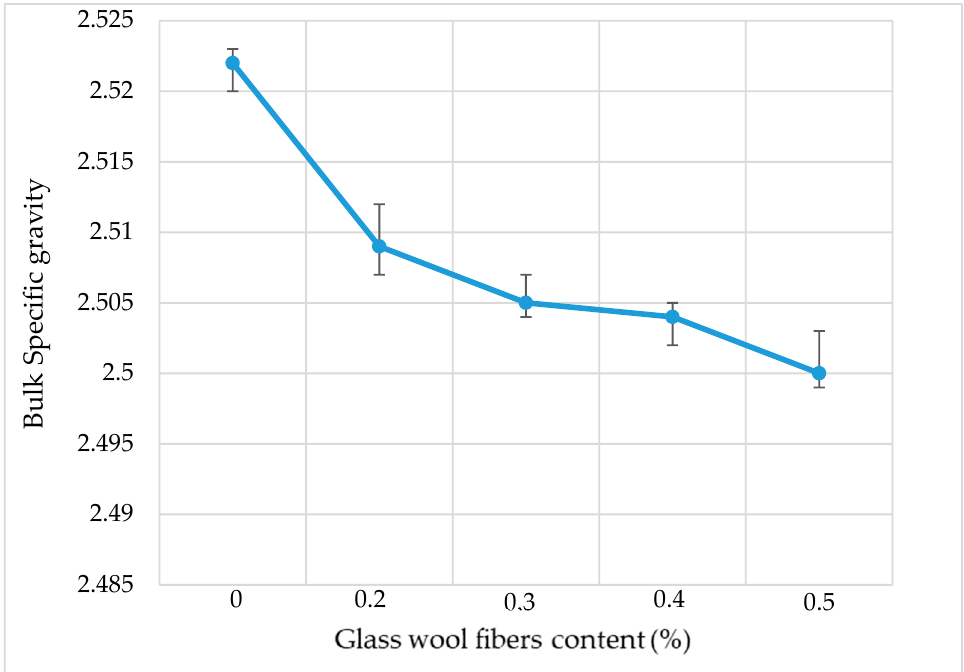
Figure 6. Bulk specific gravity .